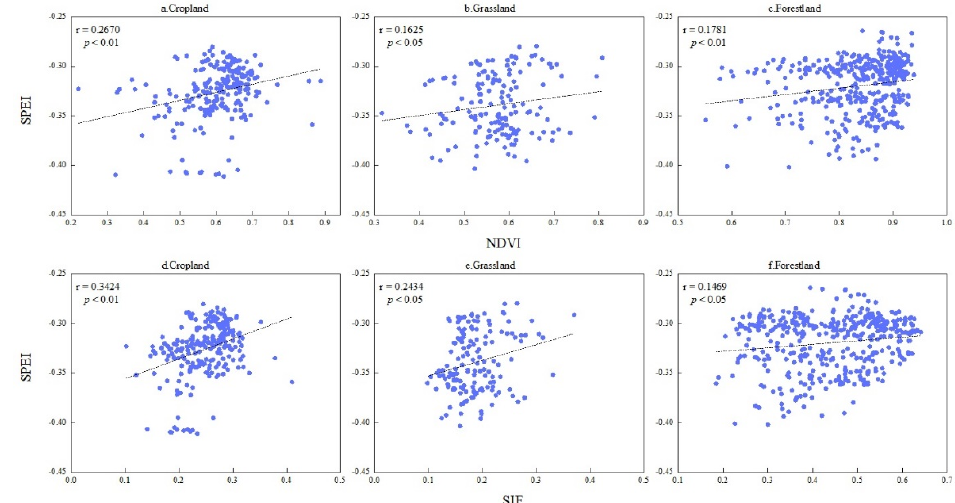
Figure 10. Correlation between SPEI and NDVI ( a ) cropland, ( b ) grassland and ( c ) forestland; correlation between SPEI and SIF ( d ) cropland, ( e ) grassland and ( f ) forestland.